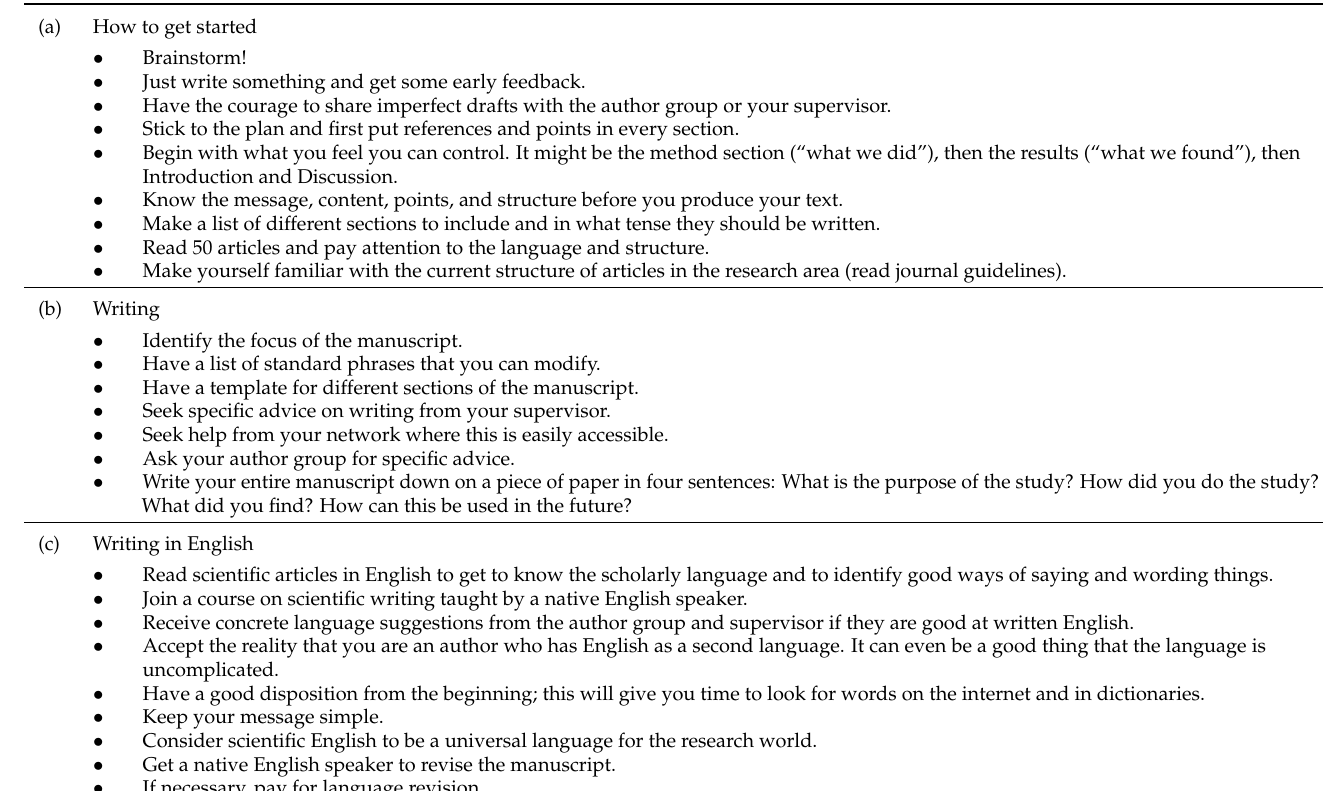
Table 3. Facilitators when getting started: participants’